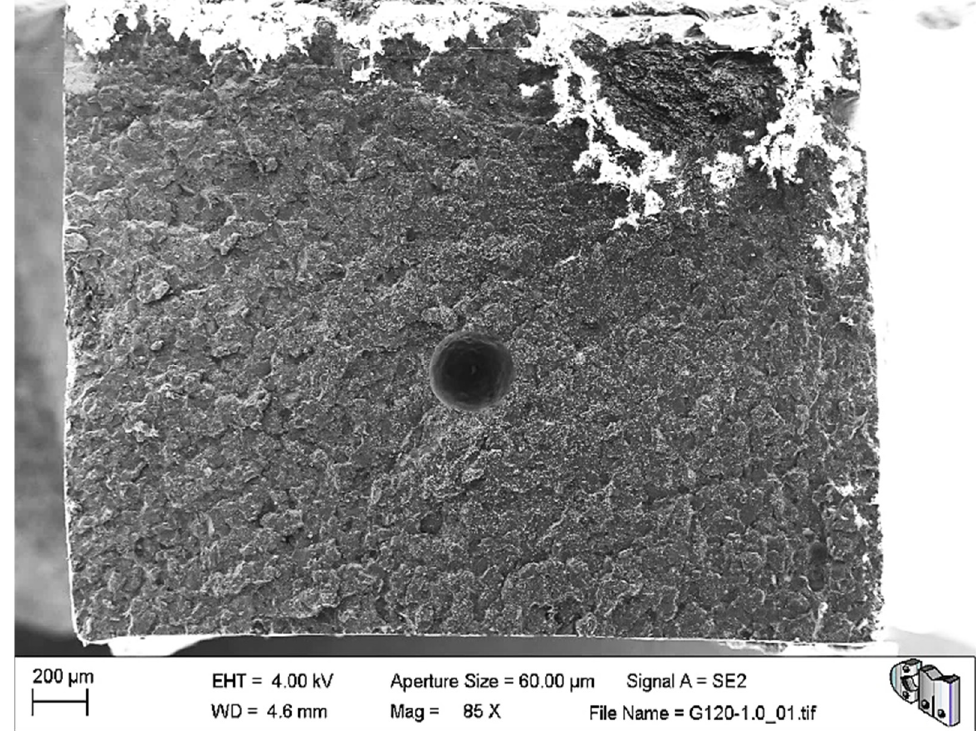
Figure 3. SEM image of the tensile fracture surface of G120-0.1. A giant air bubble can be seen trapped within the bone cement.